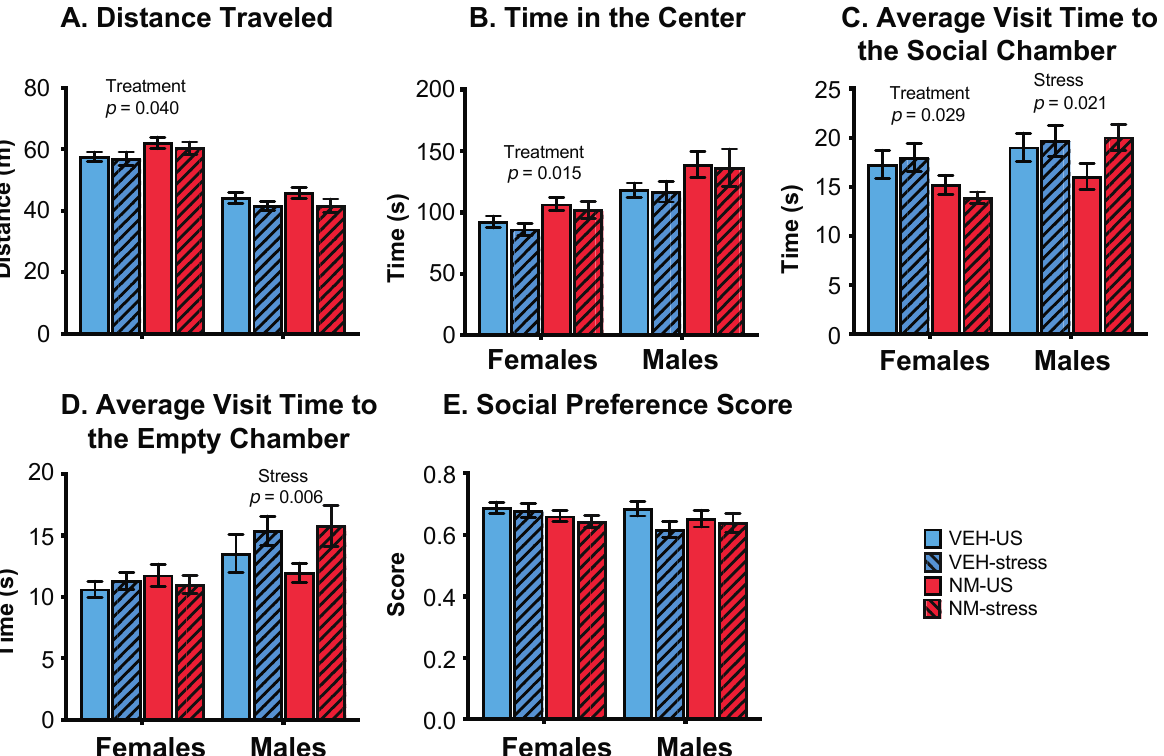
Figure 4. Effects of prenatal NeuroMix and/or stress in adolescence on behaviors in the sociability test in which rats were offered a choice between a same-sex conspecific vs. an empty cage. ( A ) Distance traveled and ( B ) time spent in the center chamber were increased by NeuroMix compared to vehicle in females. ( C ) Average time spent per visit to the social chamber was decreased by NeuroMix treatment in females, and increased by stress in males. ( D ) Average time spent per visit to the empty chamber was increased by stress in males. ( E ) Social preference score was unaffected. Sample sizes for vehicle–unstressed, vehicle–stress, NeuroMix–unstressed, and NeuroMix–stressed females: n = 27, 19, 30 and 22; for males, n = 28, 20, 29, and 22. VEH = vehicle; NM = NeuroMix; US = unstressed. Males: There were no effects of treatment or stress on distance traveled (Figure